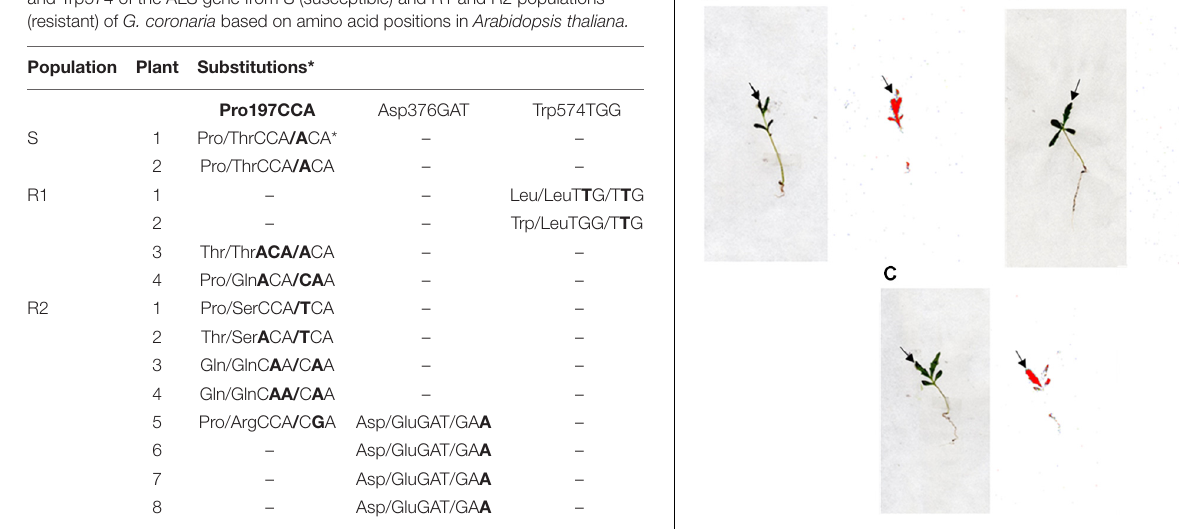
*Nucleotide changes are in bold.